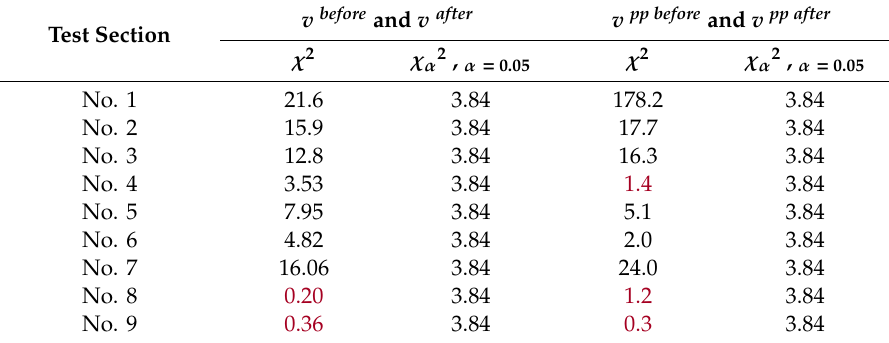
Table A6. Results of median tests on test sections (free speed v and vehicle flow speed v pp ). Test